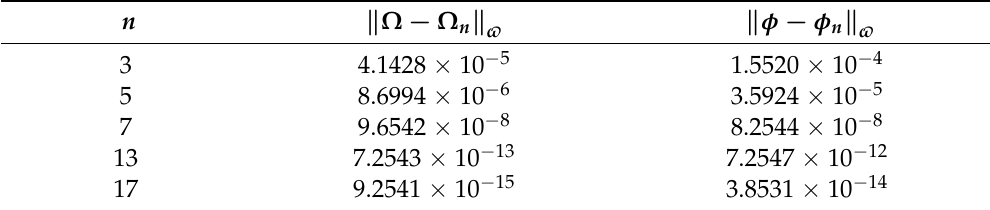
Table 1. Numerical results for Example 1.